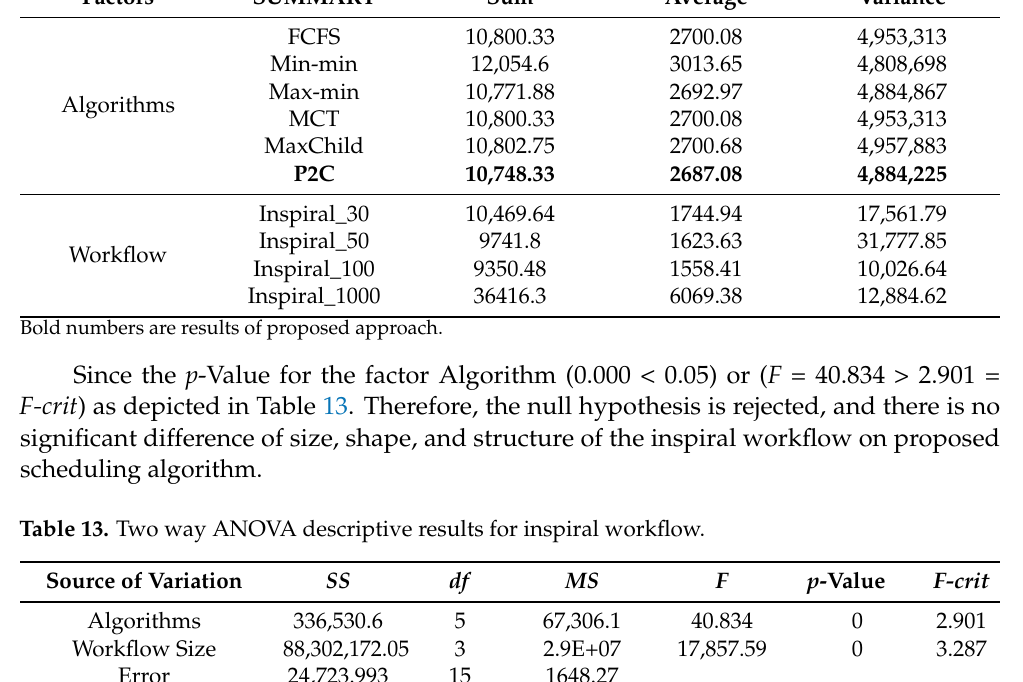
Table 12. Two way ANOVA Summary results for inspiral workflow. Factors